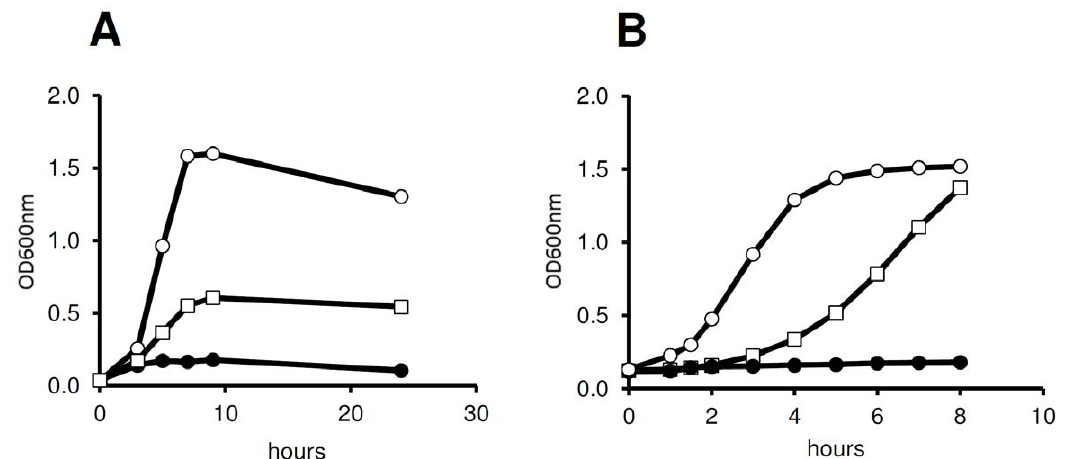
Figure 3. Rhamnose dependent growth of L.monocytogenes in batch culture. Panel A: Growth of L. monocytogenes 10403S in LB broth supplemented with glucose (50 mM, open circle) and rhamnose (50 mM, open squares), respectively. When no carbon source was added (closed circles), L. monocytogenes showed only poor growth. Panel B: Growth of L. monocytogenes LF002 ( ermC under control of P rha ) in medium supplemented with 7.5 m g/ml erythromycin. LF002 cells pre-induced with rhamnose (open squares) showed a slight delay in growth response, whereas non-induced cells (closed circles) did not multiply. L. monocytogenes strain LF003 (constitutive ermC expression) was used as positive control (open circles).